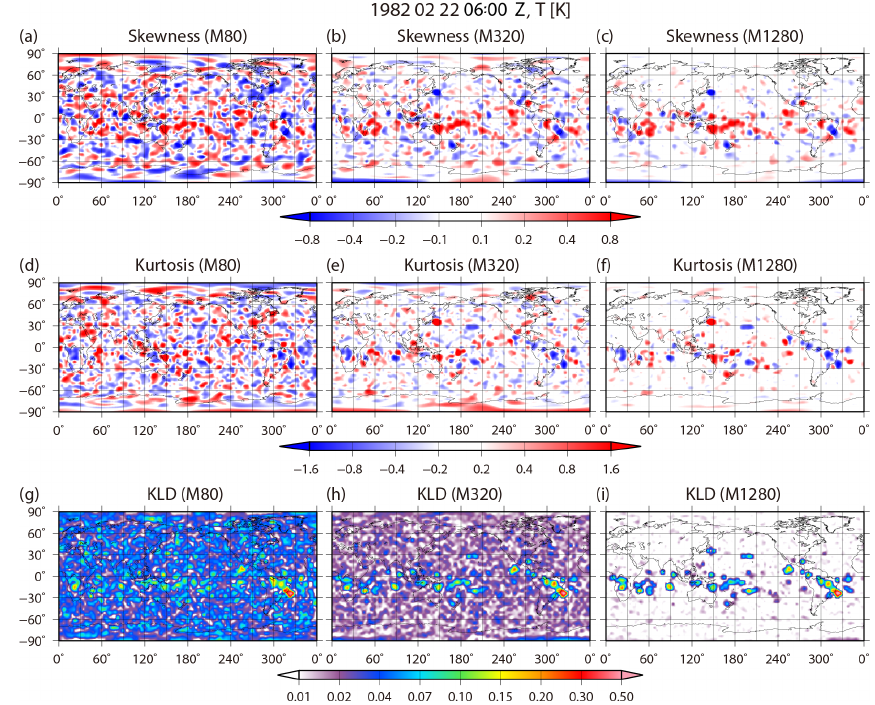
Figure 17. Spatial distributions of ( a – c ) skewness, ( d – f ) kurtosis, and ( g – i ) KL divergence for temperature at the fourth model level ( ∼ 500hPa) at 06:00UTC on 22 February. The left, center, and right columns show 80, 320, and 1280 subsamples from 10240 members,